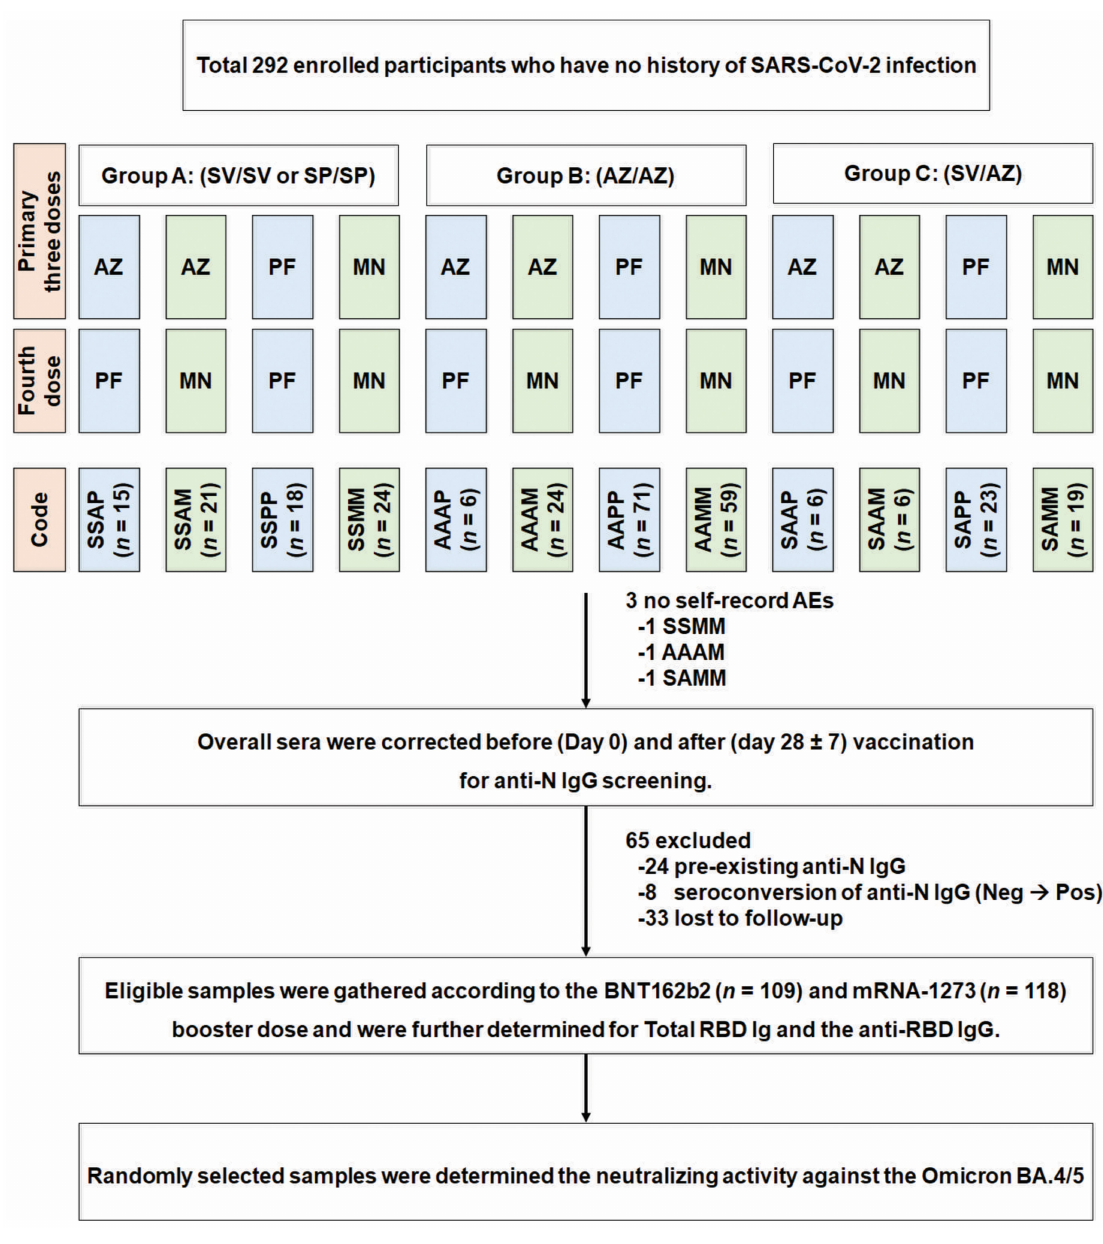
Figure 1. Study flow diagram of participants enrolled and collection of eligible samples. Individuals (18 years and older), who had previously been immunized with different three doses, were assigned to receive the fourth booster dose with 30 µ g BNT162b2 or 50 µ g mRNA-1273. Blood samples were collected on days 0 and 28 ± 7 after booster dose. Serum samples were previously screened according to the level of anti-nucleoprotein (N) IgG. Participants who had seropositive anti-N IgG (pre-existing and seroconversion) were excluded. The remaining participants were eligible for the evaluation of immunogenicity analyses after booster vaccination. Abbreviations: AEs, adverse events; A and AZ, AZD1222; Ig; immunoglobulin; M and MN, mRNA-1273; N, nucleoprotein; P and PF, BNT162b2; S, inactivated vaccine BBIBP-CorV (SP) or CoronaVac